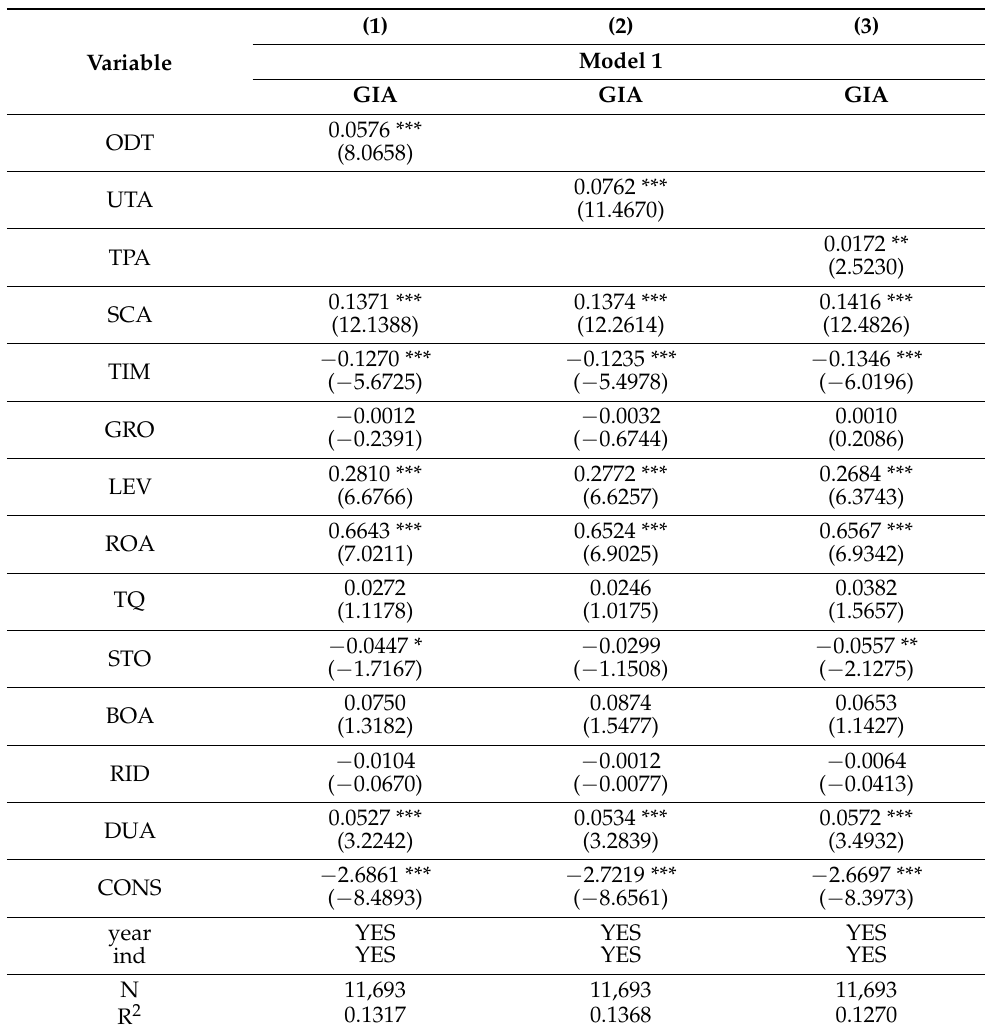
Table 10. Robustness test results